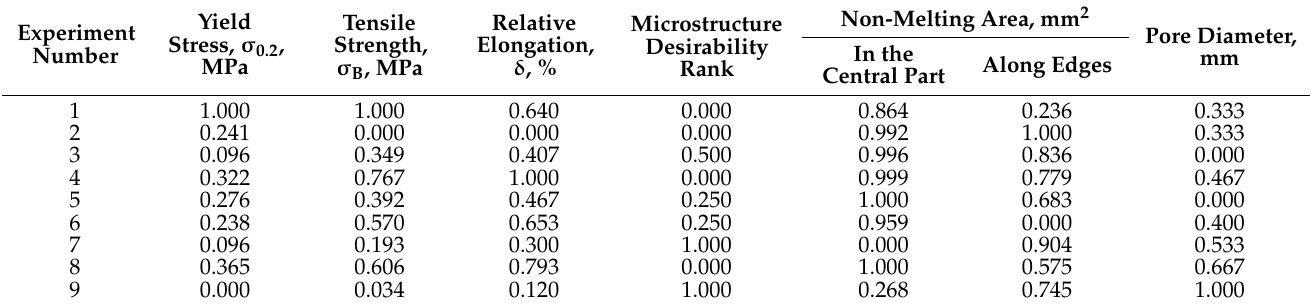
Table 7. Normalized values of the response characteristics of the